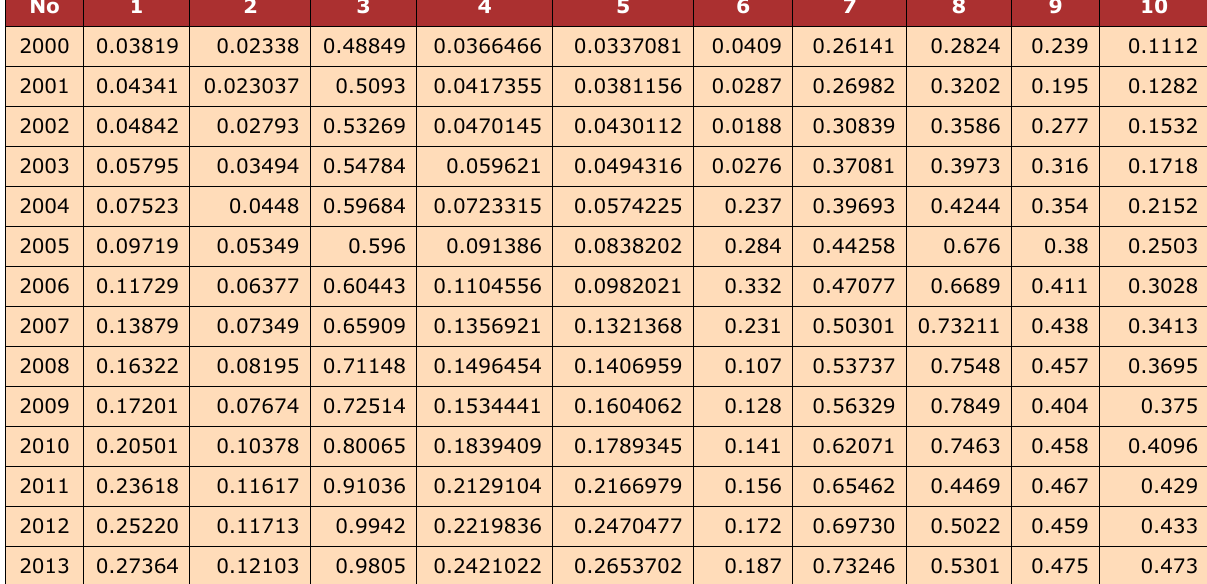
Table 3. Granular Data of Guangzhou Port Throughput Impact